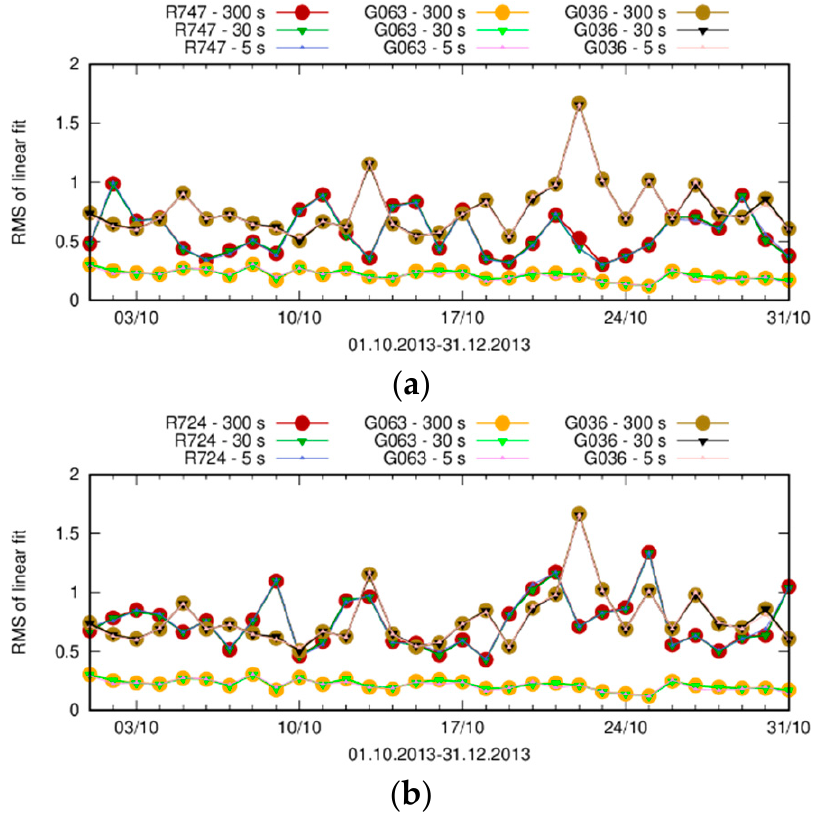
Figure 9. ( a ) Root-Mean-Square (RMS) of the linear fit for selected GNSS satellite clock corrections shown in Figure 8a. ( b ) Root-Mean-Square (RMS) of the linear fit for selected GNSS satellite clock corrections shown in Figure 8b.